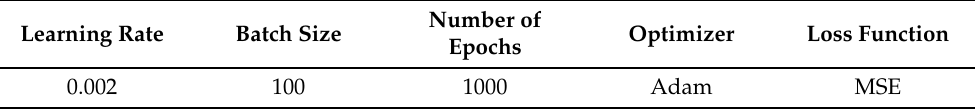
Table 2. Hyperparameters of the deep learning models. Learning